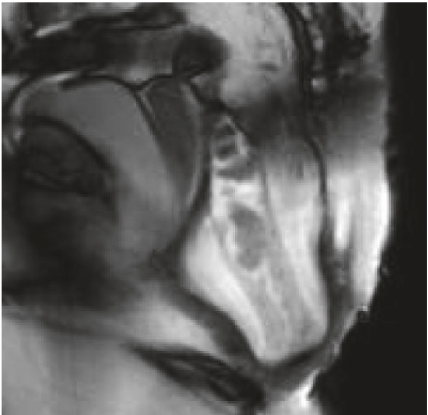
Figure 2: MR defecography showing persistent intussusception and complete rectal prolapse after failed STARR procedure performed 6 months earlier.